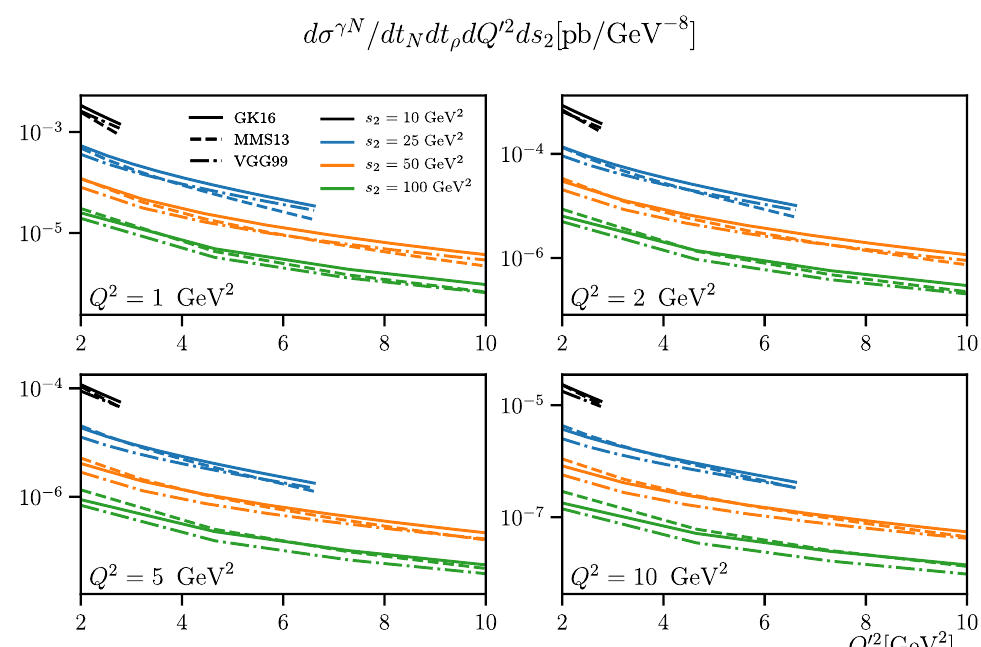
Figure 4: Diffractive ρ + dilepton photoproduction cross sections for different values = − 0.1 GeV 2 and t = t min of Q 2 at t , as a function of Q (cid:48) 2 and for various values ρ ρ N of s (color), with three different GPD models (line style), see [ 2 ] for 2